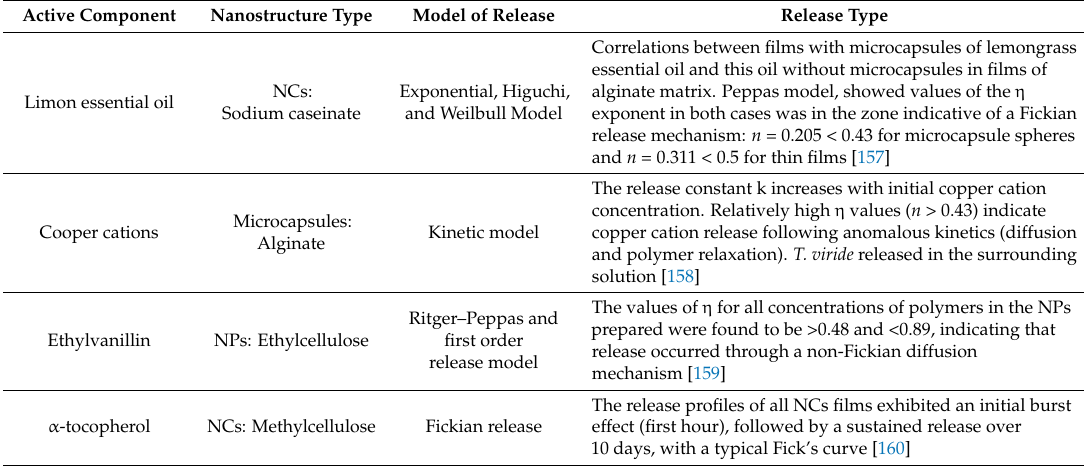
Table 7. Recent studies on delivery and kinetics of nanostructures in edible